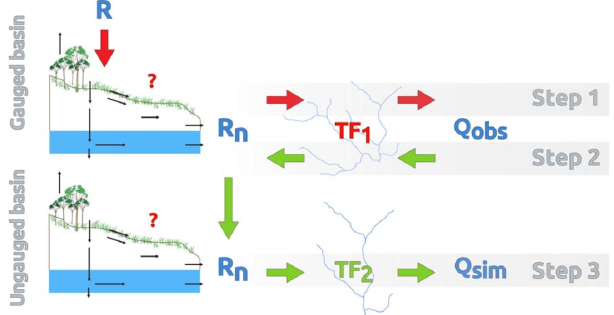
Figure 2. Deconvolution of the observed discharge series Q obs of the donor gauged basin through the inversion of its geomorphology- based transfer function TF 1 , generalization of net rainfall to a sim- ilar target basin, and simulation of the discharge series Q sim at the outlet of the target (pseudo)-ungauged basin through the convolu- tion with its transfer function TF 2 (from de Lavenne et al., 2015).